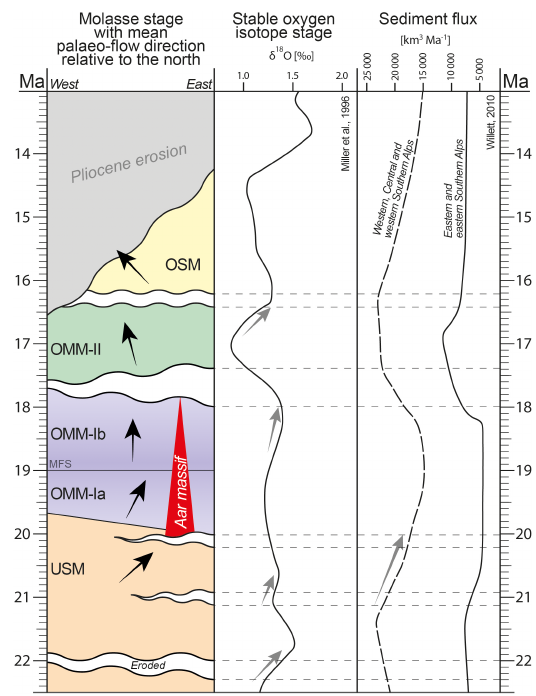
Figure 8. Molasse stages (USM, OMM, and OSM) with mean palaeo-transport directions (black arrows), hiatuses plotted against stable oxygen isotope stages (Miller et al., 1996), and sediment flux (Kuhlemann, 2000; Willet, 2010). The red triangle demarcates the onset of delamination and rapid exhumation of the Aar massif (Her- wegh et al., 2017). Grey arrows demarcate decreases in sediment flux and falls in the eustatic sea level, possibly contributing to the related hiatuses. MFS: maximum flooding